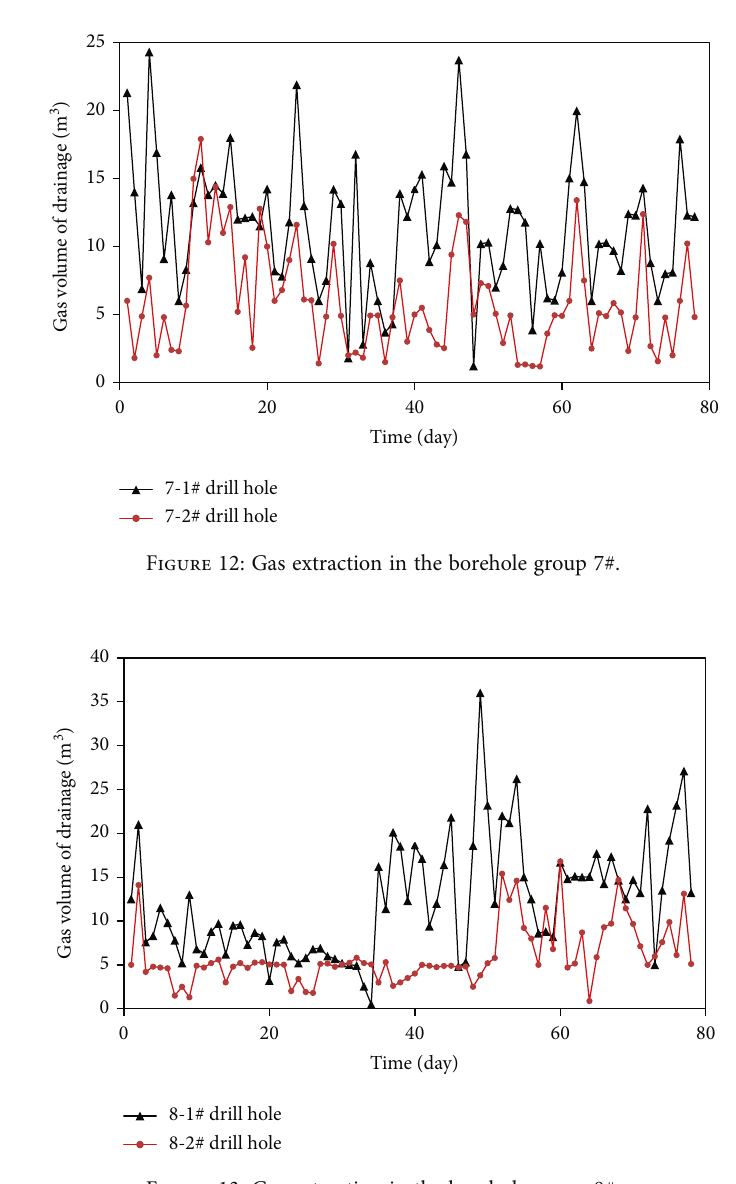
Figure 13: Gas extraction in the borehole group